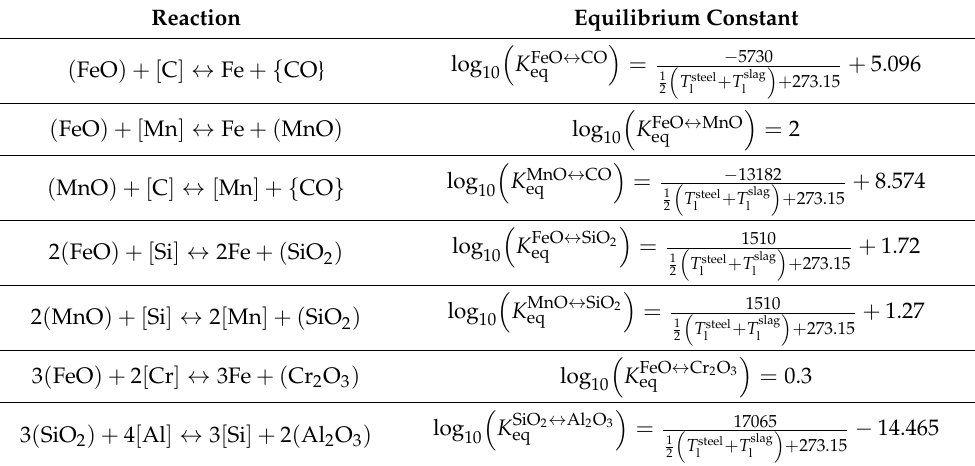
Table A2. Equilibrium constants for reactions. T l denotes liquid phase temperatures. Reaction Equilibrium